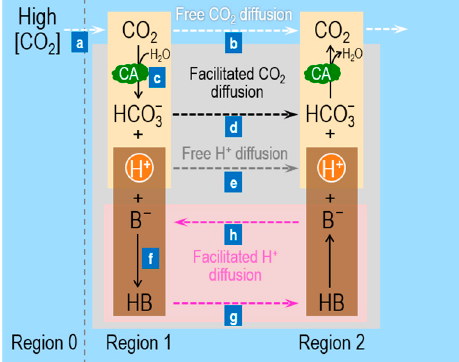
that have di ff used from Region 1 and form CO 2 .